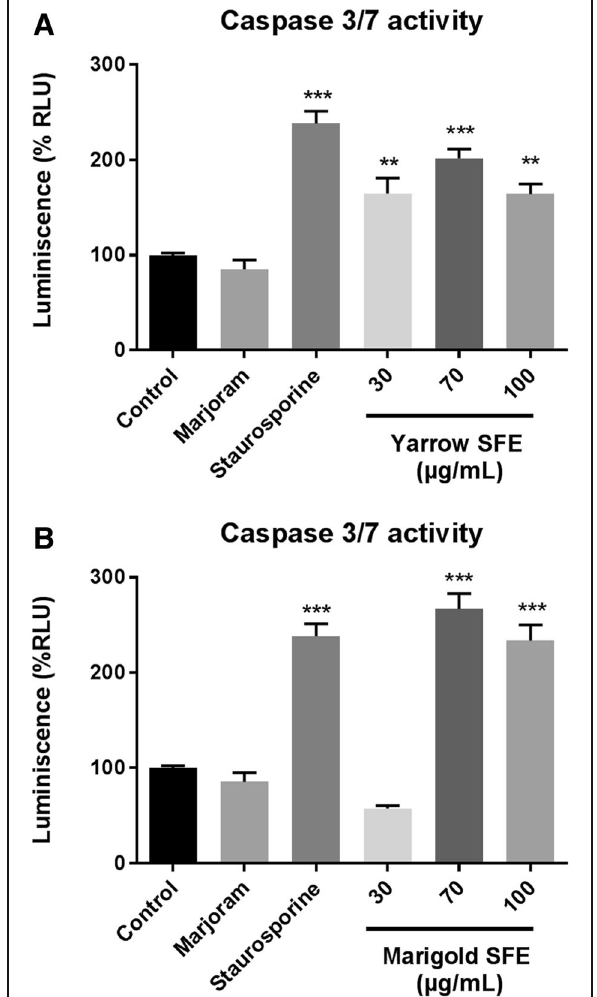
Fig. 4 Apoptosis triggered by treatment with Asteraceae plant extracts on MIA Paca-2 cells. Activation of caspase 3 and 7 after 48 h treatment with Yarrow SFE extracts ( a ) or with Marigold SFE extracts ( b ), with the positive (Staurosporine 1,5 μ M) and negative (Marjoram SFE 100 μ g/mL) controls. Data represent means ± S.E.M of three independent experiments each performed in duplicate. Asterisks indicate statistical differences in treated cells with respect to the control (non-treated cells, DMSO 0.1%). ** p < 0.01; *** p <